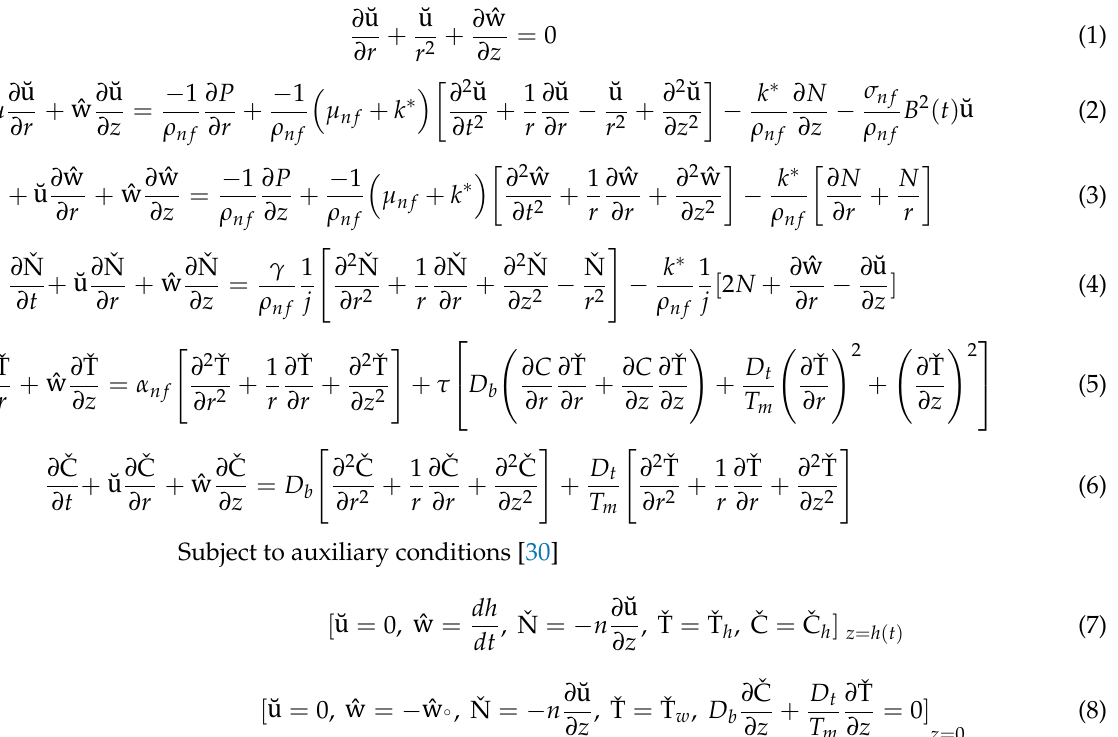
Figure 1. Geometry of the problem .